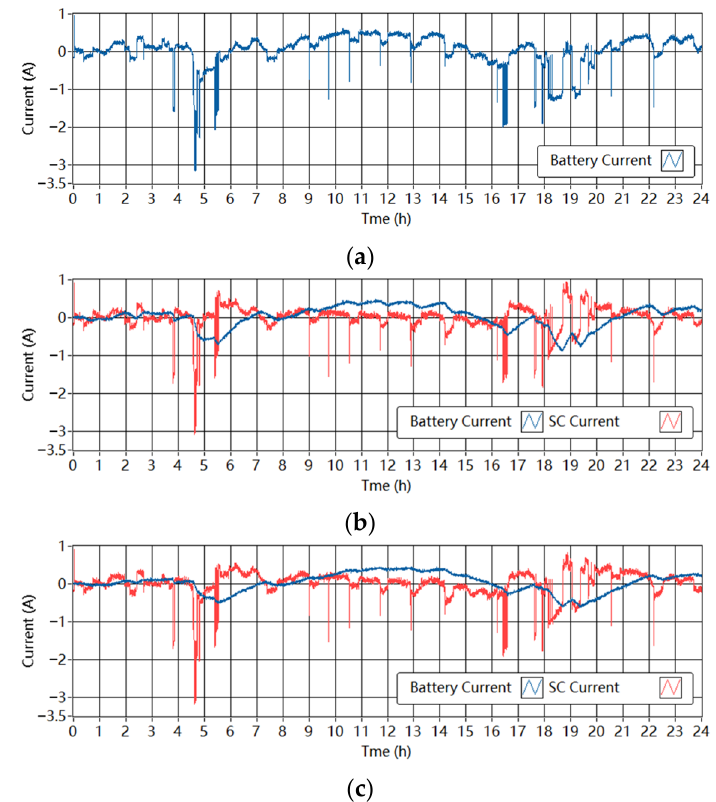
Figure 12. Measured currents through the ESDs in the experimental setup in the wind-powered system. ( a ) Single-battery ESS ( b ) Battery-SC HESS when T f is 1800 s. ( c ) Battery-SC HESS when T f is 3600 s.